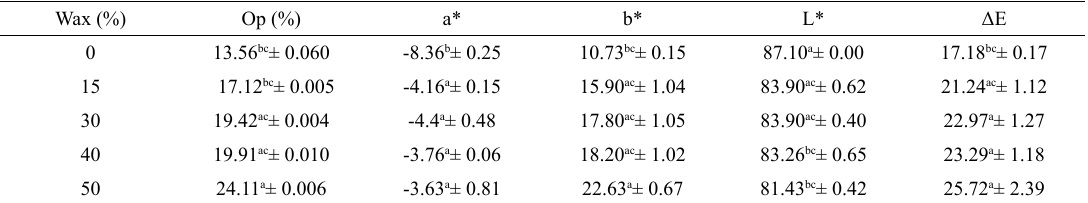
Different lowercase letters in superscript mark significantly different mean values within the same Table 2. Mean values for water vapor permeability (WVP) and thicknesses for different carnauba wax percentages. Carnauba wax (%)